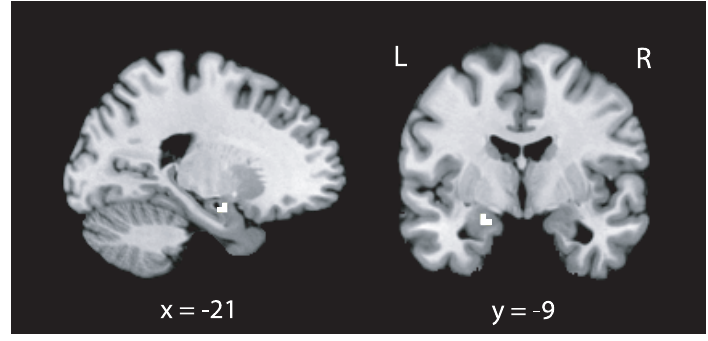
Figure 3. Brain regions activated in associative memory formation (Association remembered . Association forgotten). Sagittal view ( left ) and coronal view ( right ) show the activation in the left hippocampus (MNI -21 -9 -15, SVC, p =0.029). Images are thresholded at p , 0.001 uncorrected, for displaying purposes. L, left; R, right. doi:10.1371/journal.pone.0013147.g003 PLoS ONE |